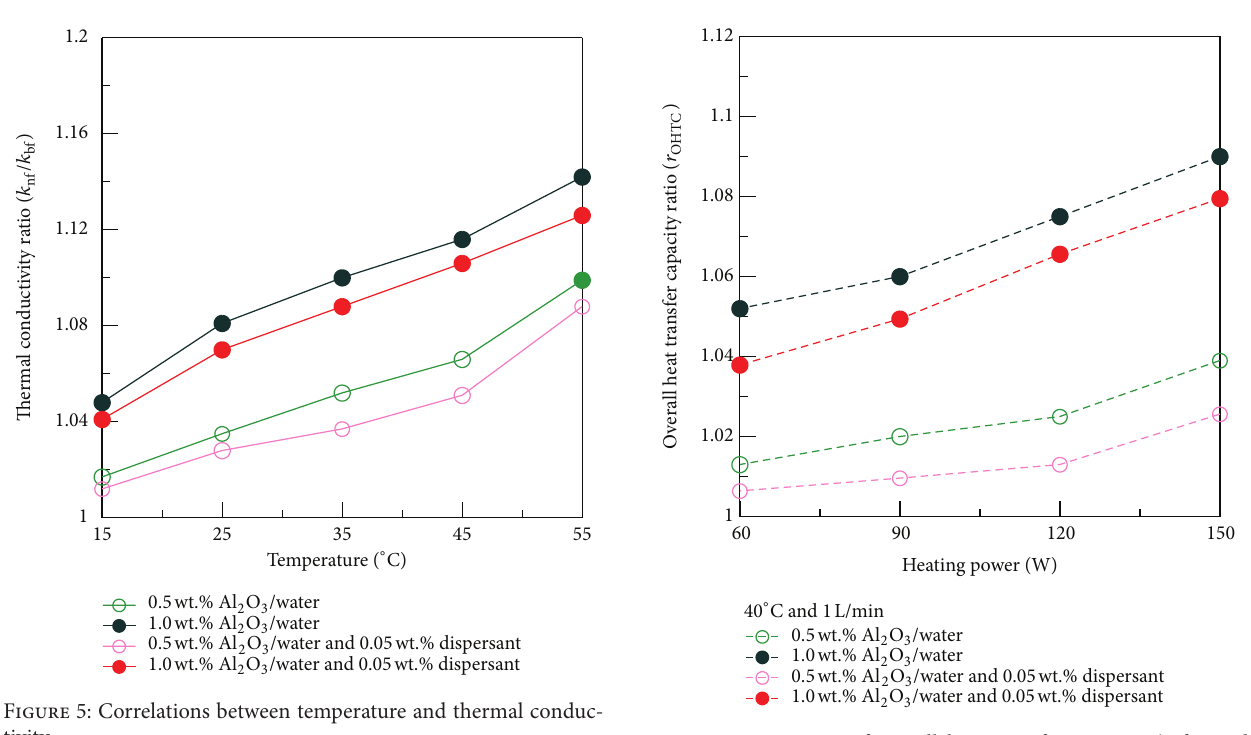
Figure 7: Increment of overall heat transfer capacity (40 ∘ C and 1L/min).